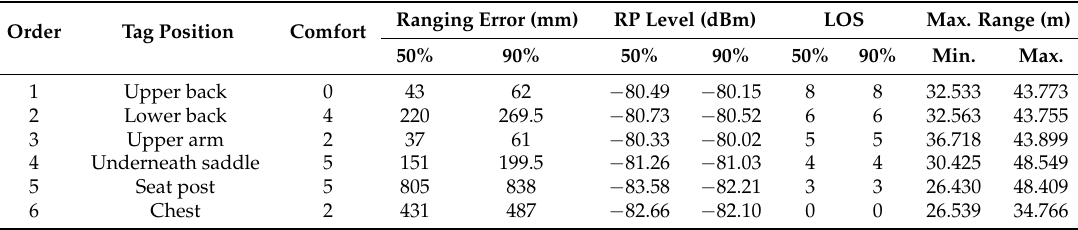
Table 6. Overview results: anchor height: 2.3